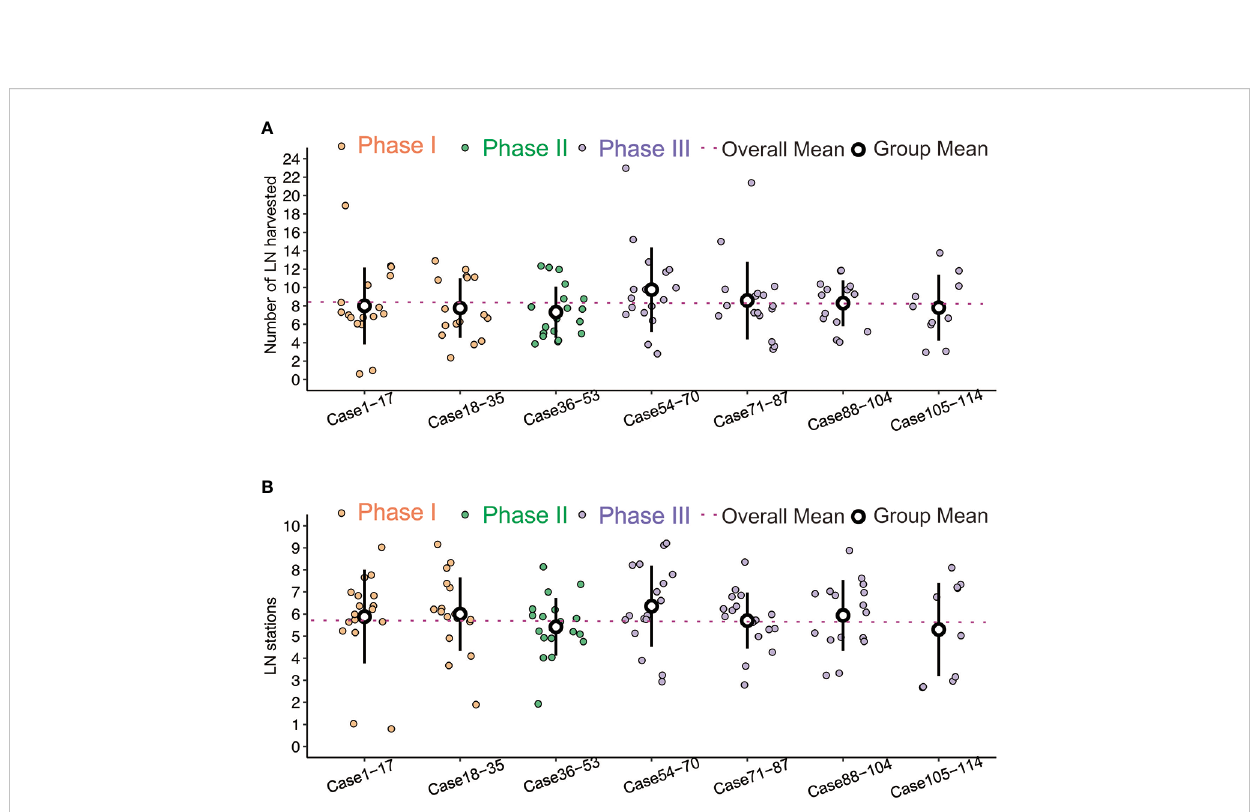
FIGURE 3 (A) Comparisons of LN harvested number, no signi fi cant difference between the three phases. (B) Comparisons of LN station, no signi fi cant difference between the three